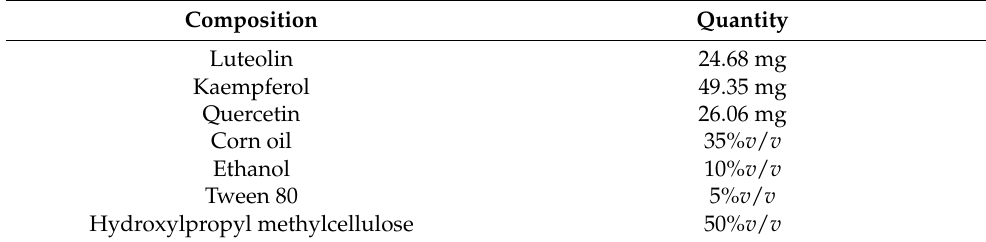
Table 3. Nutraceutical composition of ProFine TM